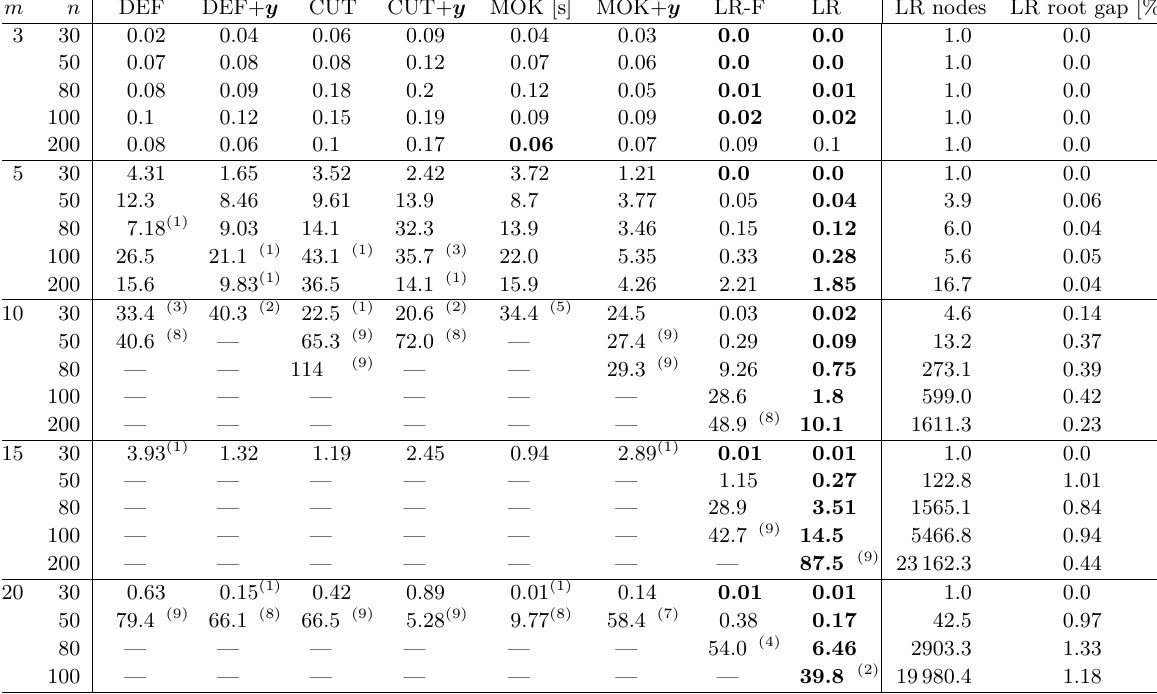
Table 2 The average computing time [s] for solving ten correlated jobs instances of size m × n